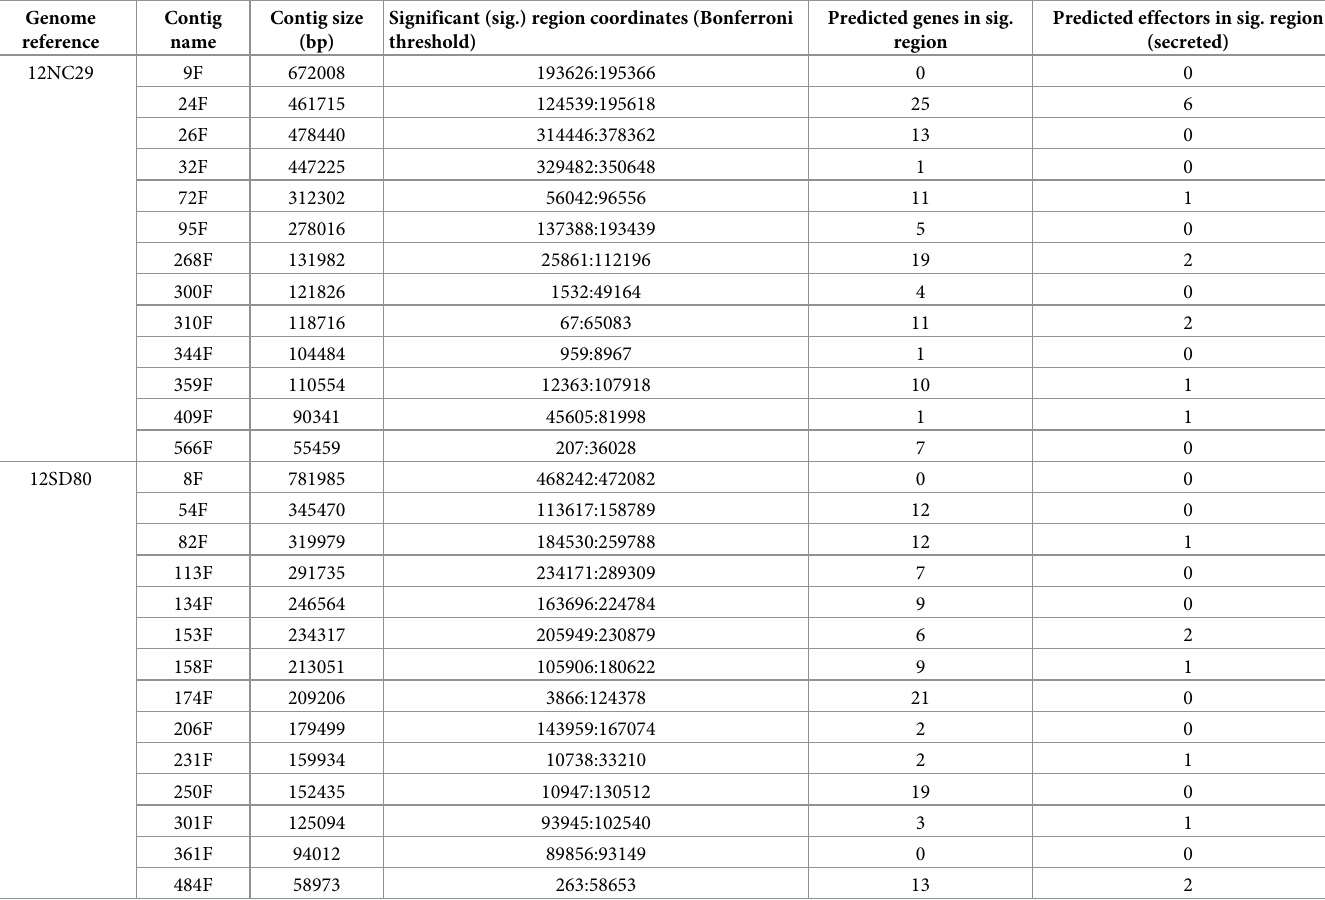
Table 1. Genomic regions and gene content in 12NC29 and 12SD80 identified through a genome-wide association of virulence to specific R genes. Genome